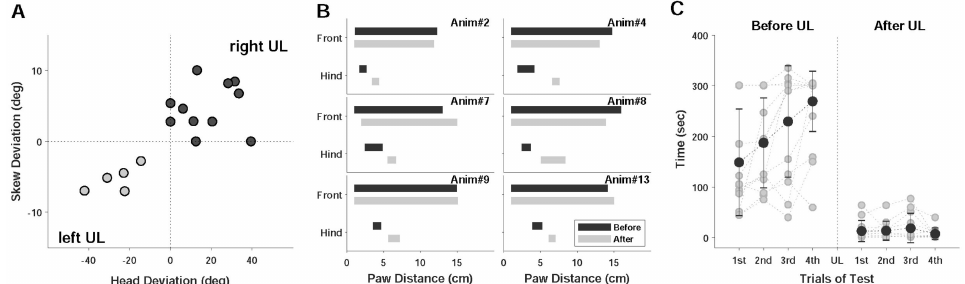
Figure 2. Behavioral responses before and after UL. ( A ) Relation between the degree of the head (HD) and the ocular skew deviation (SD). ( B ) Front and hind paw distances from 6 selected animals: Each bar represents the range of paw distance. ( C ) Rota-rod tests: For each condition, animals were tested 4 times.